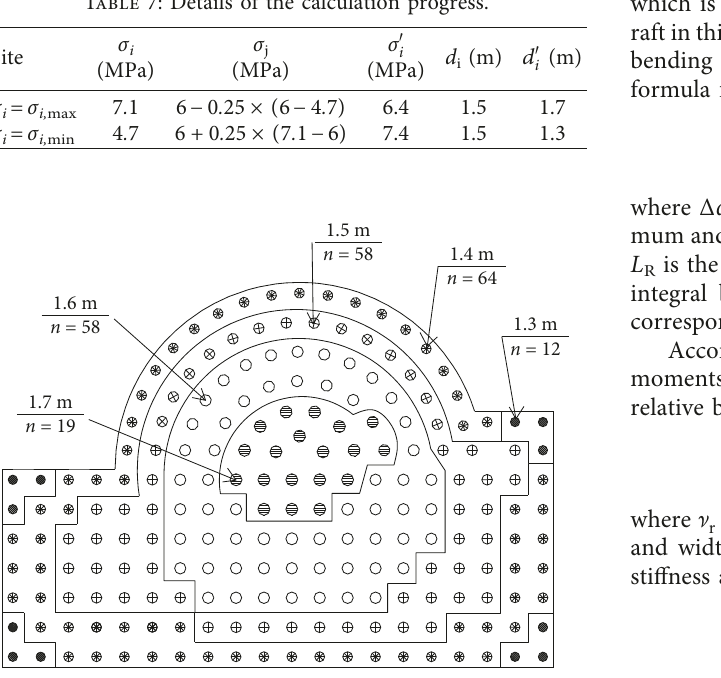
Figure 8: Final optimized configuration with different pile di- ameters (scheme 1).